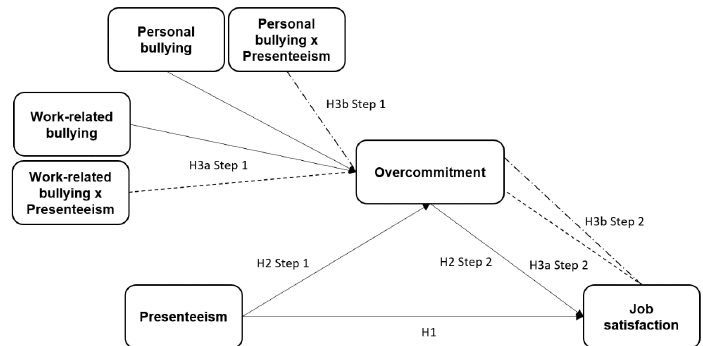
Figure 1. Graphical model of the hypotheses where the relationships between variables are